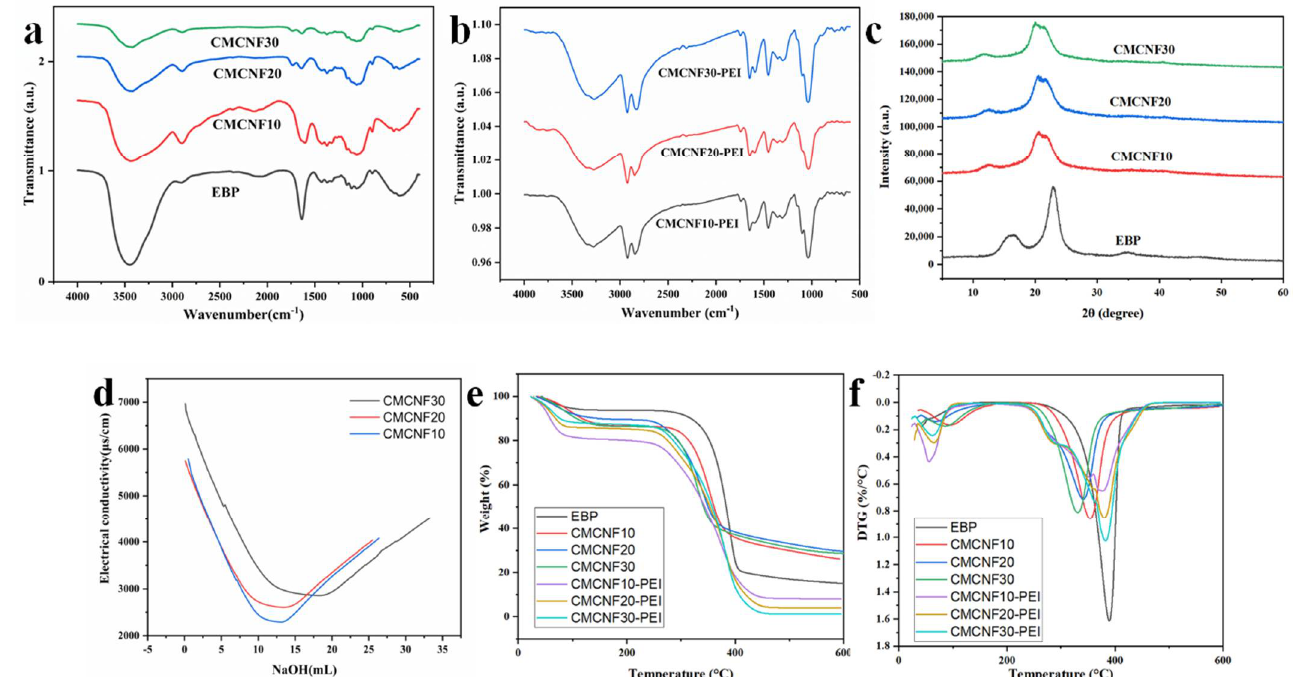
Figure 1. FTIR spectra of ( a ) EBP, CMCNFs, ( b ) CMCNFs-PEI, ( c ) XRD spectra of EBP and CMCNFs, ( d ) illustration of approach used for determination of carboxyl group in CMCNFs, ( e ) TGA, and ( f ) DTG curves of all samples.